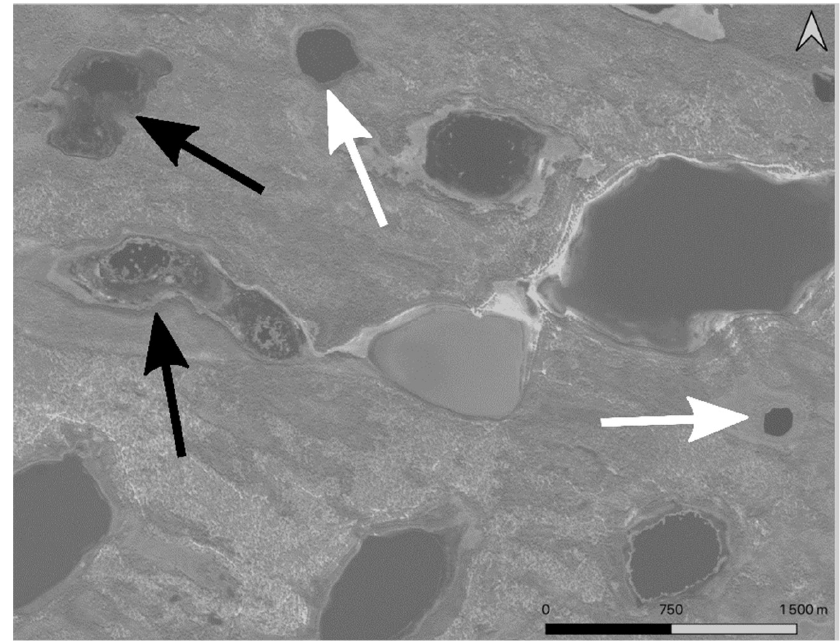
Figure 3. Image showing different lake boundaries. Black arrows are pointing to fuzzy boundaries. White arrows are pointing to clear boundaries.